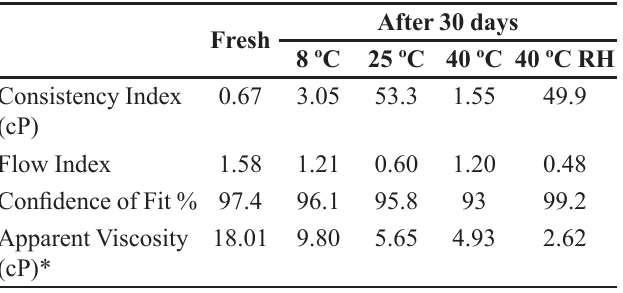
TABLE IV - Results of Rheological analysis of MeA fresh sample and samples stored at different conditions for 30 days